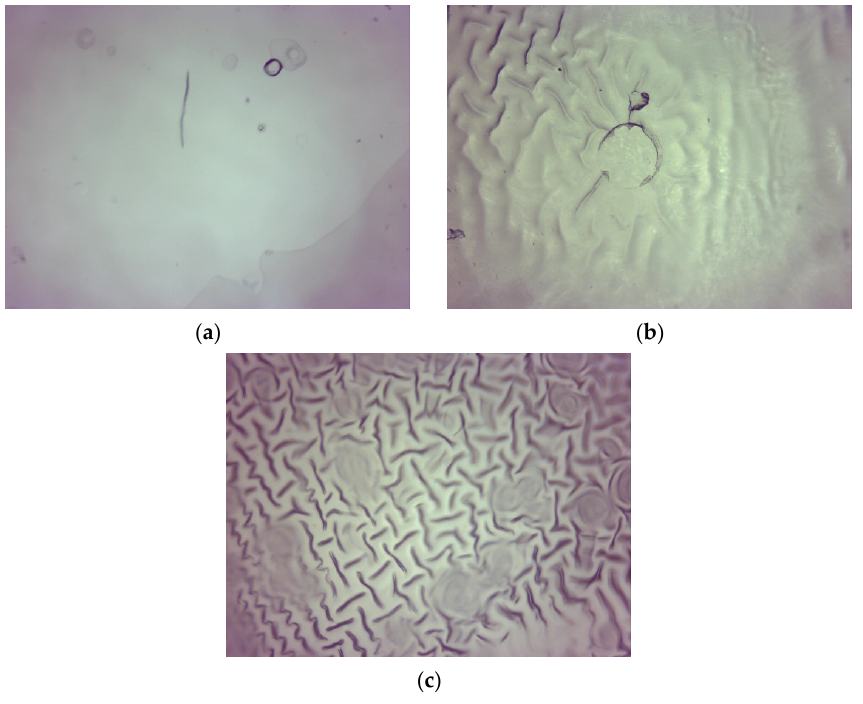
Figure 1. Optical image of sample 575/7.5 ( a ), 575/10.0 ( b ), and 575/12.5 ( c ).